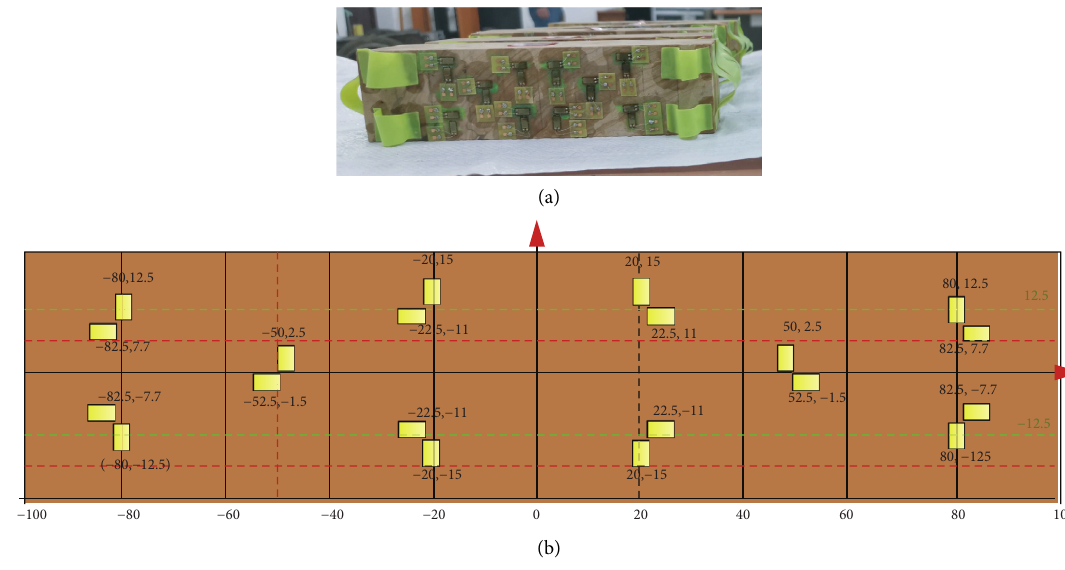
Figure 1: Sample preparation. (a) Typical samples. (b) Strain